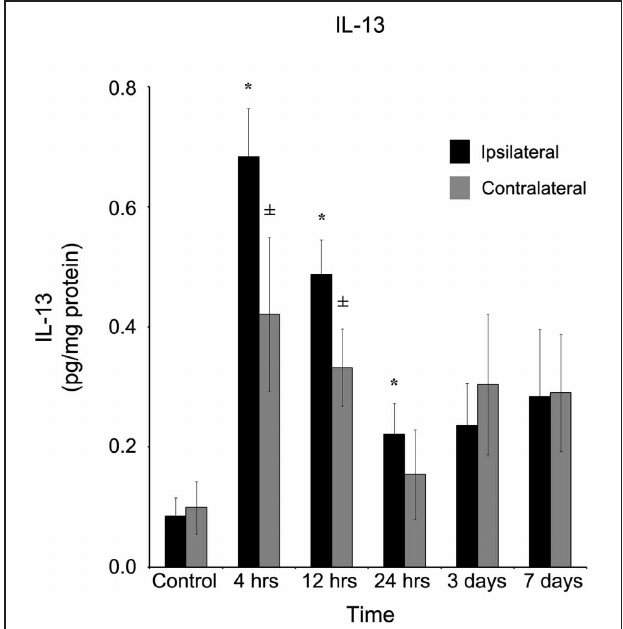
FIGURE 4 | IL-13 concentration increases in both the ipsilateral and contralateral cortex following a controlled cortical impact. Within four hours of a brain injury, TNF- α increases ( p < 0 . 05) in both the ipsilateral and contralateral cortex in comparison to control tissue. There was no difference ( p > 0 . 05) in the ipsilateral and contralateral hemispheres at any time point measured. However, while the contralateral returned to levels no different from control ( p > 0 . 05) within 24 hours, the IL-13 remained elevated ( p < 0 . 05) in comparison to control until three days post-injury. All values are mean ± SEM, n = 5. ∗ At each time point noted, ipsilateral differs from control tissue, p < 0 . 05. ± At each time point noted, contralateral differs from control tissue, p < 0 . 05.